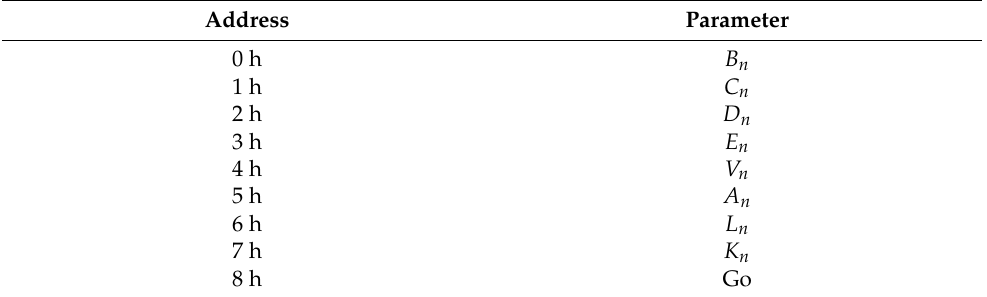
Table 2. Addresses of the parameters in the input Avalon memory mapped